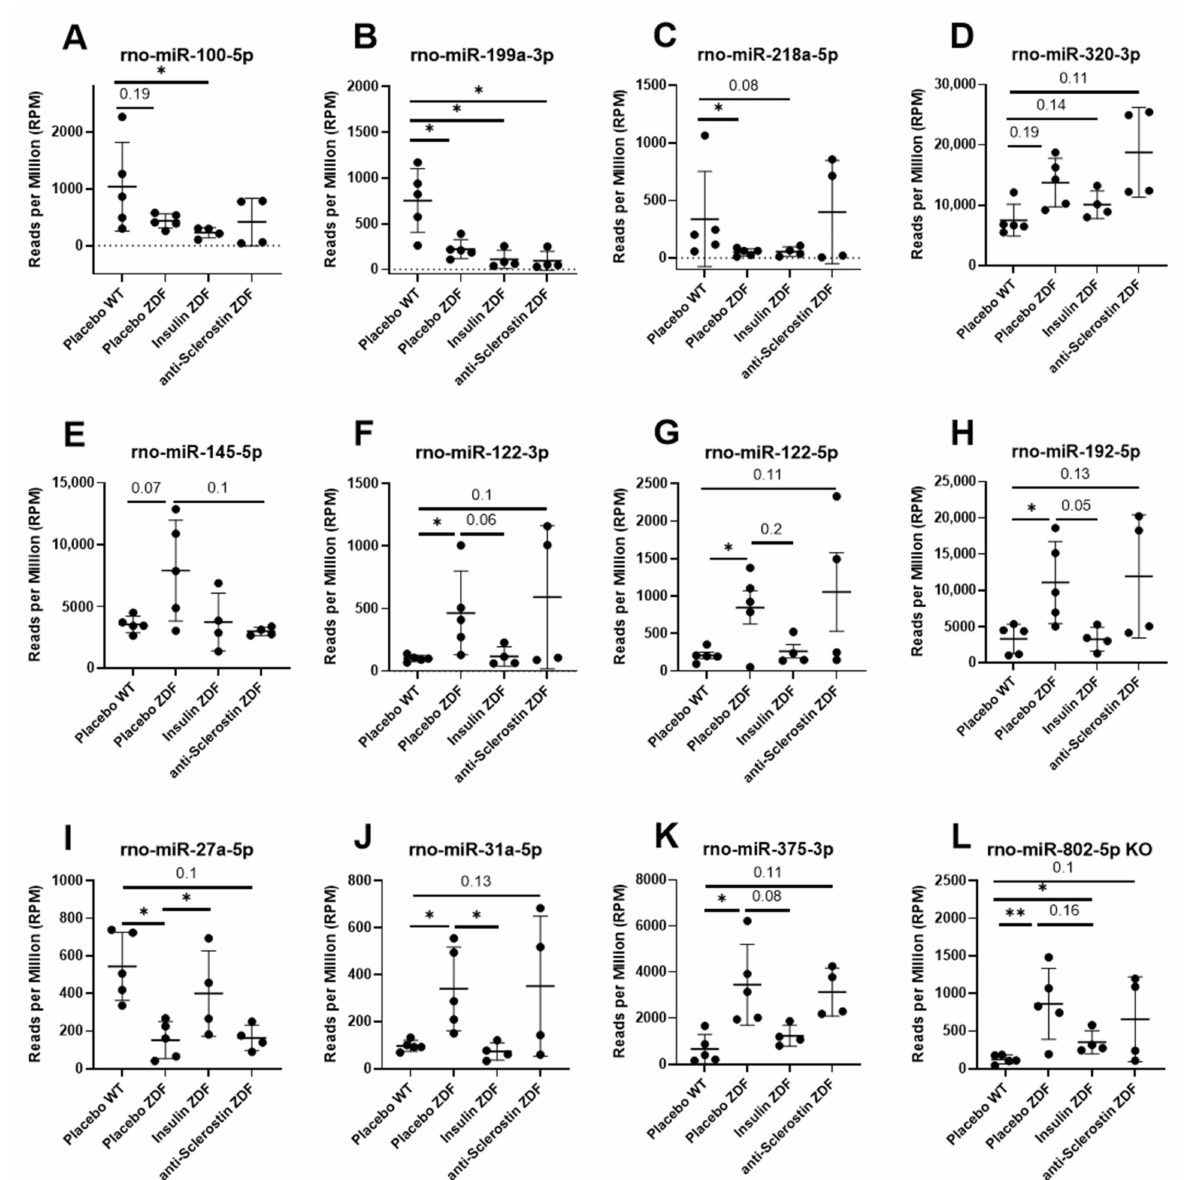
Figure 4. MicroRNA scatter plots. Representation of circulating miRNAs not rescued by any treat- ment ( A – D ), rescued by anti-sclerostin ( E ), or insulin ( F – L ) treatments. Placebo WT, n = 5; placebo ZDF, n = 5, PTH ZDF, n = 5; insulin ZDF, n = 4; anti-scl ZDF, n = 4. Scatterplots show mean ± SD. Testing was performed using edgeR as described in the Materials and Methods Section. FDR < 0.1 shown in numeric values, * FDR < 0.05, ** FDR <